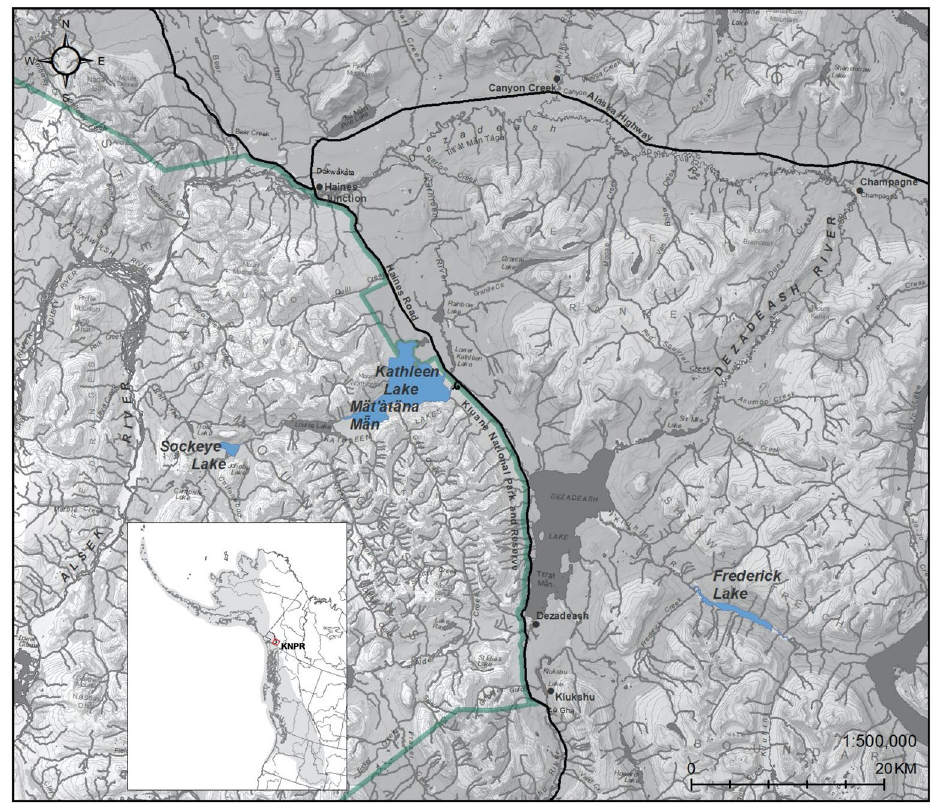
Figure 1. Map of lakes (blue) sampled in Kluane National Park and Reserve (KNPR) (green boundary line) and surrounding area, and the location of KNPR within the North American range of kokanee (inset); map of kokanee distribution (inset) is based on 77 . The base map was modified from 78